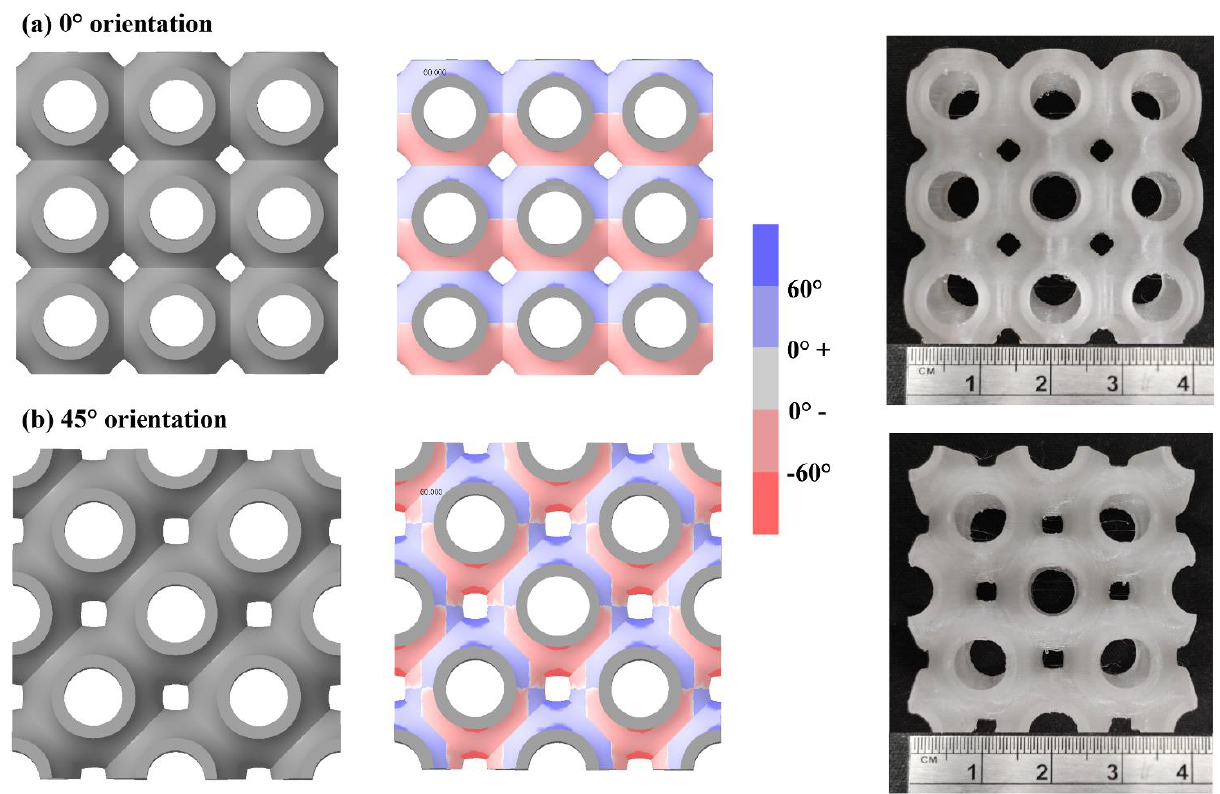
Figure 4. CAD design, draft analysis and additive manufacturing of SU lattice structure in ( a ) 0° orientation and ( b ) 45° orientation.